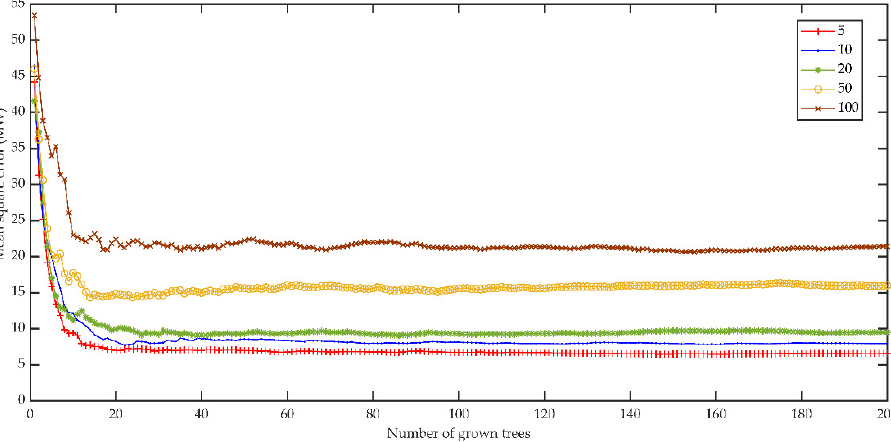
Figure 15. Importance estimates of predictors with random forests for thermal energy production.